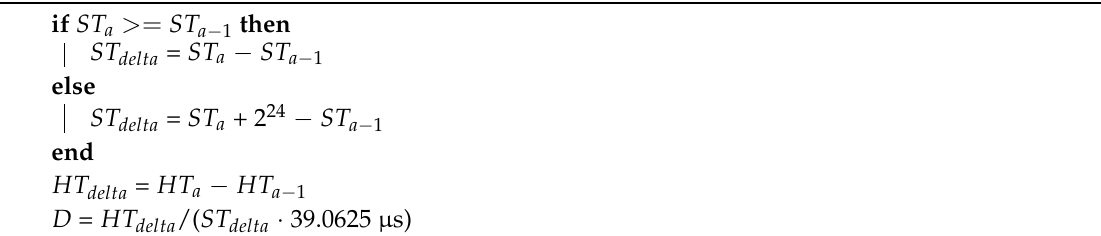
Algorithm 1: Simple drift calculation. Sensor time stamps ST are given as 24 bit values, while the related host time stamps HT are already scaled in µ s.